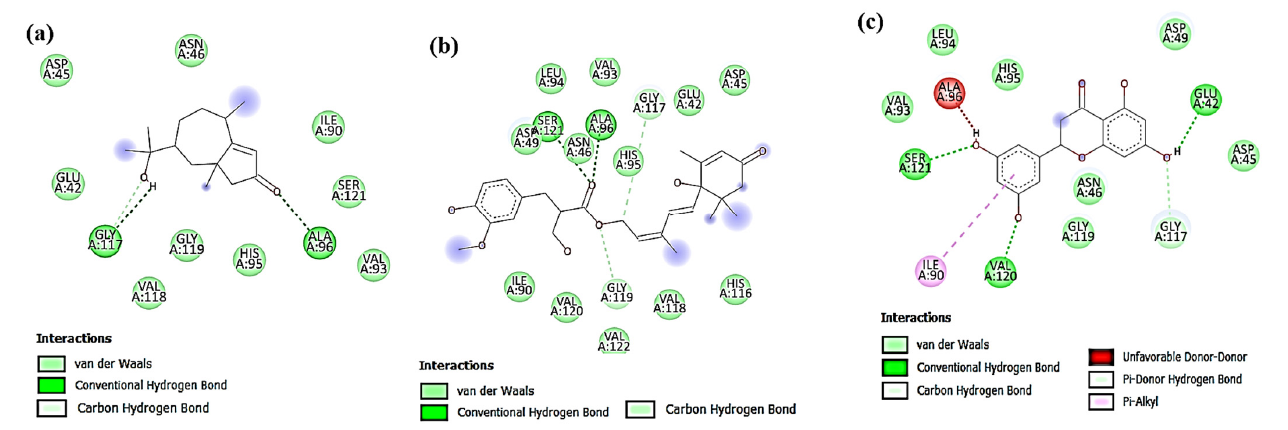
Figure 4. Two-dimensional (2D) molecular interactions of ( a ) Compound C3 ; ( b ) Compound C5 ; and ( c ) Compound C7 with the active site of DNA gyrase topoisomerase II ( E. coli ) enzyme (PDB ID:1KZN), (dimensions X:21.0176, Y: 30.3575, Z:27.6357), (root mean square deviation) RMSD < 2.